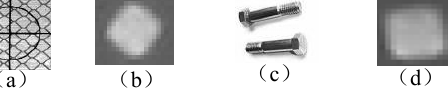
（ c ） Figure7. Figure (a) is the reflecting mark’s picture, and (b) is the imagery. Figure (c) is the picture of rivets, and (d) is the imagery.